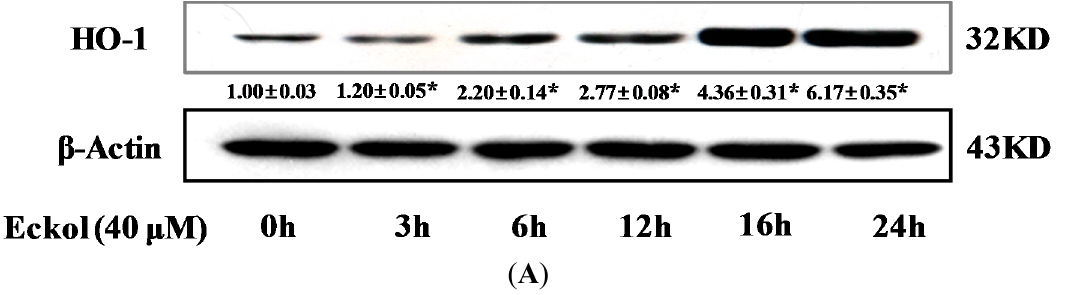
Figure 3. Effects of eckol on expressions of HO-1 in HepG2 cells. ( A ) Cells were treated with 40 μ M eckol with indicated time and equal amounts of total proteins were subjected to SDS-PAGE; ( B ) Cells were treated with eckol for 16 hr and equal amounts of total proteins were subjected to SDS-PAGE. The expressions of HO-1 and β -actin protein were detected by Western blot using specific antibodies. Isolated RNA was reverse-transcripted and amplified by PCR using specific primers. Values are the mean ± SD of three independent experiments. * p < 0.05 indicates significant differences compared to the control